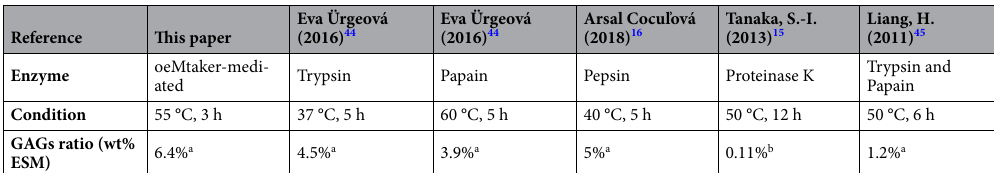
Table 3. The glycosaminoglycans content in the solubilized ESM by difference proteases. a Quantification is measured by carbazole assay. b Quantification of the data is a commercially available hyaluronic acid measurement kit (Seikagaku